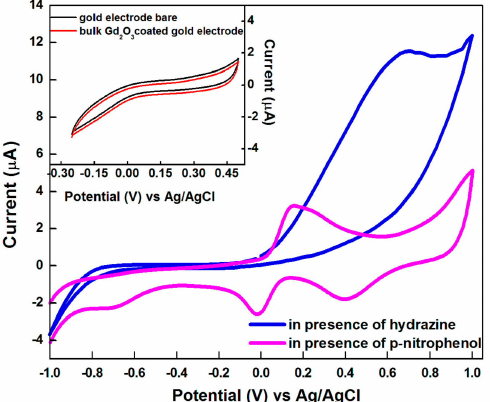
Figure 3. Cyclic voltammograms for a Gd 2 O 3 nanoparticles-coated gold electrode under various electrode conditions in 0.1 M PBS (pH 7.0). The scan rate was 60 mV / s and the respective concentrations of analyte was kept constant at 1